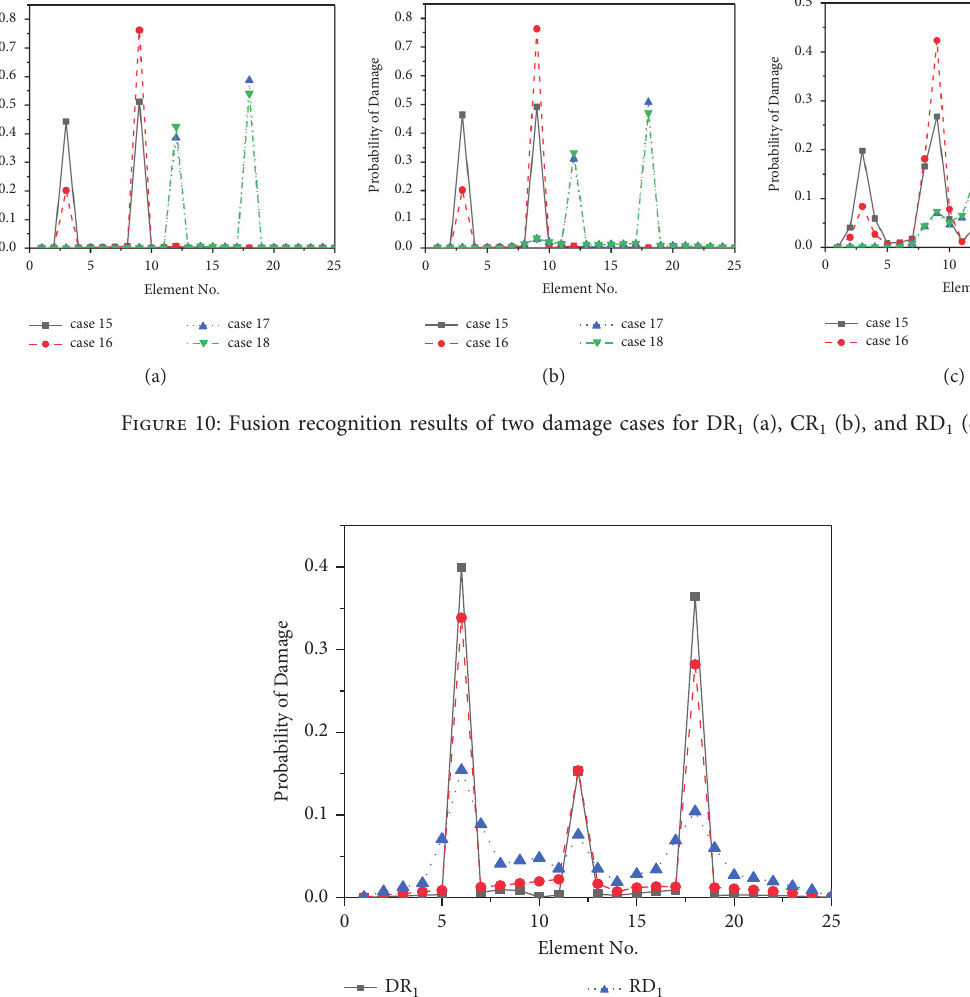
Figure 11: Fusion recognition results of multiple damage (case